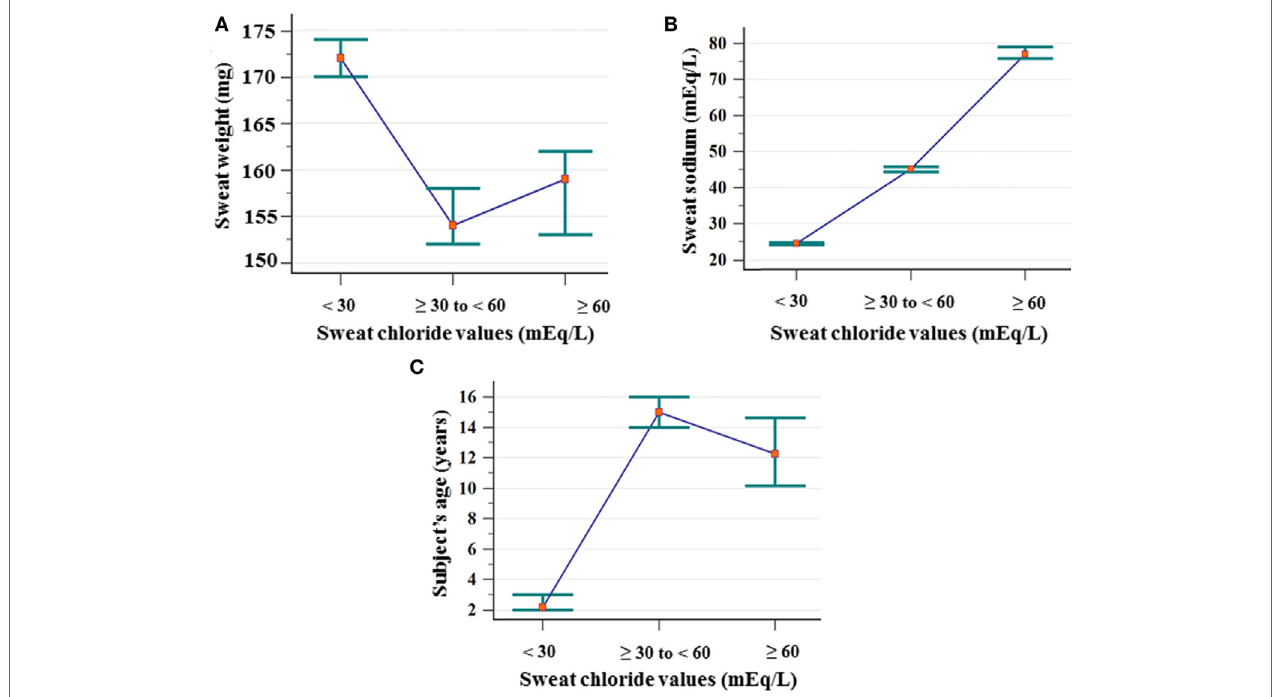
FigUre 1 | Association between the ST results considering chloride cutoff values and sweat weight (mg), sodium value (mEq/L), and subject’s age (years). (a) Sweat weight: (chloride < 30 mEq/L) N = 3,249; mean of 175 ± 43; median of 172 (amplitude from 75 to 367); (chloride ≥ 30 to < 60 mEq/L) N = 1,326; mean of 162 ± 41; median of 154 (amplitude from 78 to 299); (chloride ≥ 60 mEq/L) N = 702; mean of 164 ± 42; median of 159 (amplitude from 78 to 326). Chloride < 30 mEq/L ≠ chloride ≥ 30 to < 60 mEq/L, and chloride ≥ 60 mEq/L. (b) Sweat–sodium concentration: (chloride < 30 mEq/L) N = 3,249; mean of 25.24 ± 7.03; median of 24.4 (amplitude from 10 to 68.5); (chloride ≥ 30 to < 60 mEq/L) N = 1,326; mean of 45.82 ± 9.89; median of 45.11 (amplitude from 20.3 to 81.8); (chloride ≥ 60 mEq/L) N = 702; mean of 80.54 ± 17.98; median of 77 (amplitude from 42.9 to 149.7). All groups differ from each other. (c) Subject’s age: ( < 30 mEq/L) N = 3.233; mean of 6.66 ± 11.91; median of 2.17 (amplitude from 0 to 76.33); (chloride ≥ 30 to < 60 mEq/L) N = 1,282; mean of 24.34 ± 21.74; median of 15 (amplitude from 0 to 85.58); (chloride ≥ 60 mEq/L) N = 621; mean of 21.27 ± 22.52; median of 12.25 (amplitude from 0 to 81.17). All groups differ from each other. Statistical analysis was performed by Kruskal–Wallis test. P -value for all analyses was < 0.001. α = 0.05. The median is set in red marker and the 95% confidence interval is set in green line. mEq/L, milliequivalents per liter; ST, sweat